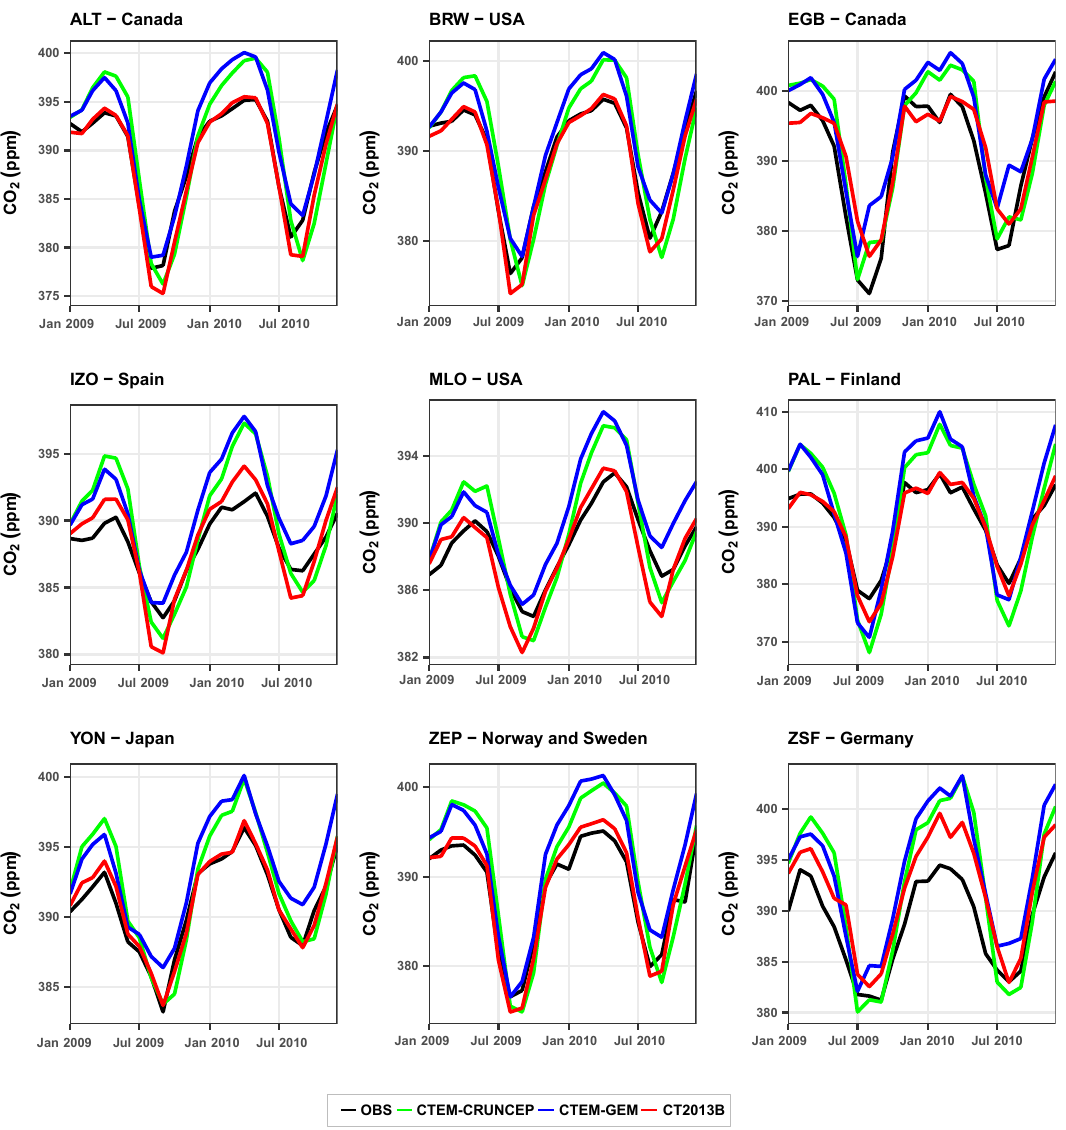
Figure 10. Comparison of the monthly time series of modeled CO 2 concentrations using land prior fluxes from CTEM-CRUNCEP (green) and CTEM-GEM (blue) with surface observations (black) at selected sites (listed in Table 1), and modeled CO 2 using posterior fluxes from CT2013B (red). The modeled CO 2 was produced by a forward run of